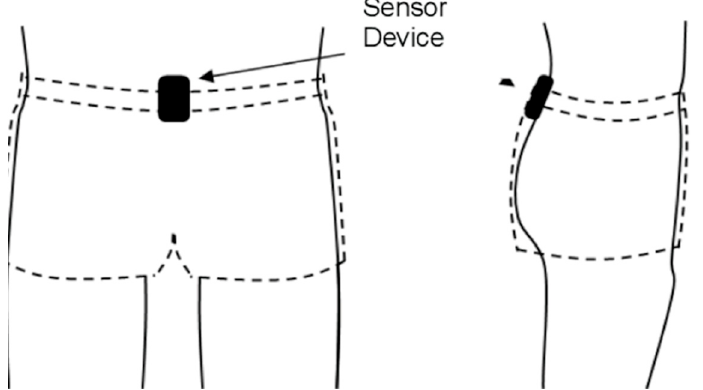
Figure 1. Wearable device on a belt, positioned at the sacrum.